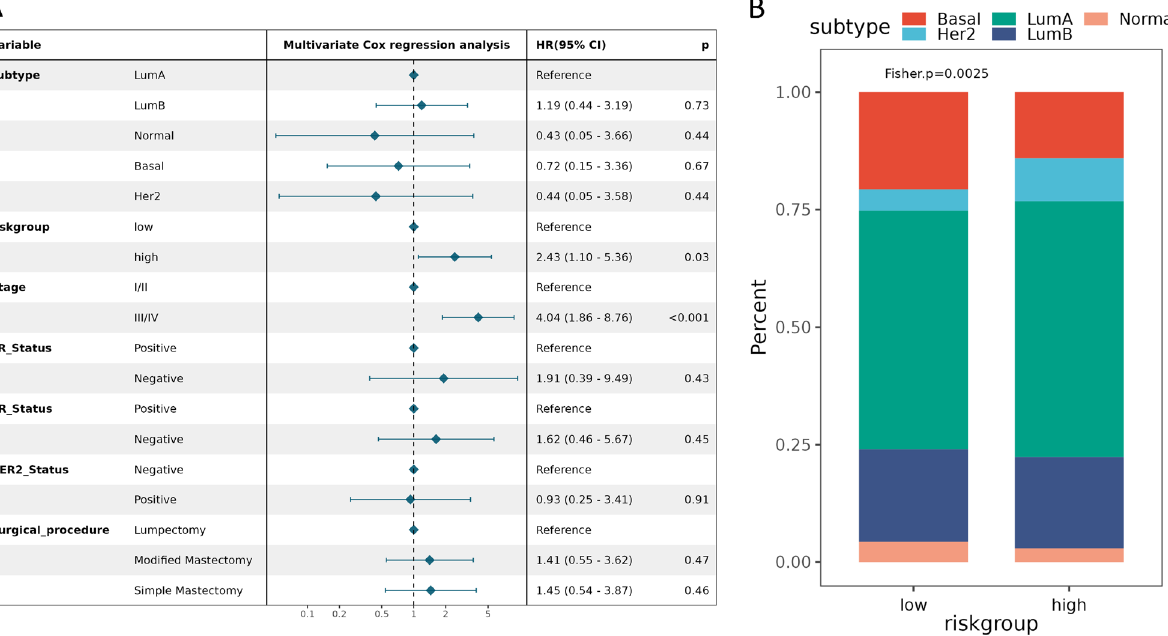
Figure 10. The multivariate regression analysis was performed in combination with the clinical factors and the distribution of molecular subtypes. ( A ) The multivariate regression analysis was performed in combination with the clinical factors. ( B ) The distribution of molecular subtypes in their high and low risk